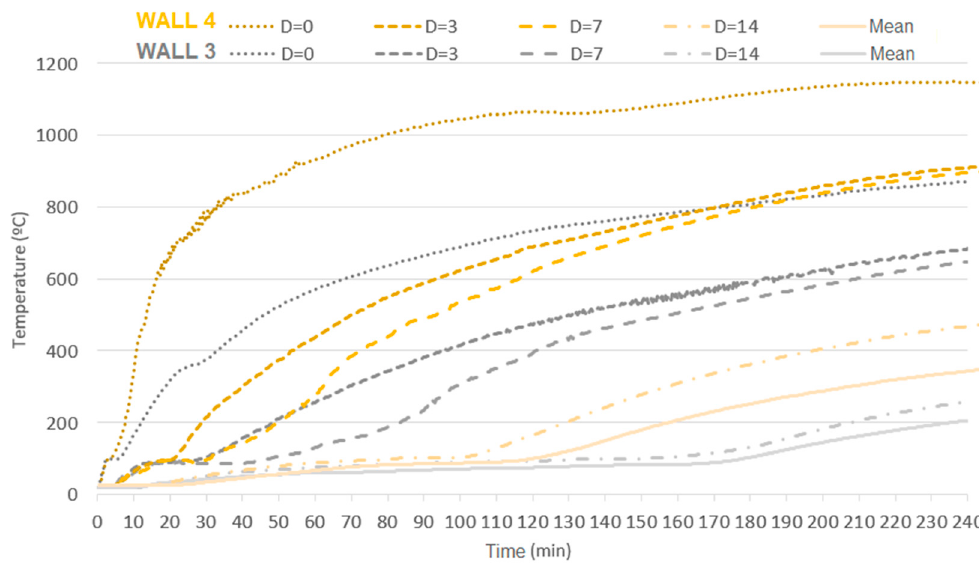
Figure 21. Development of the temperature over time on masonries with 15 mm of coating on the fire-